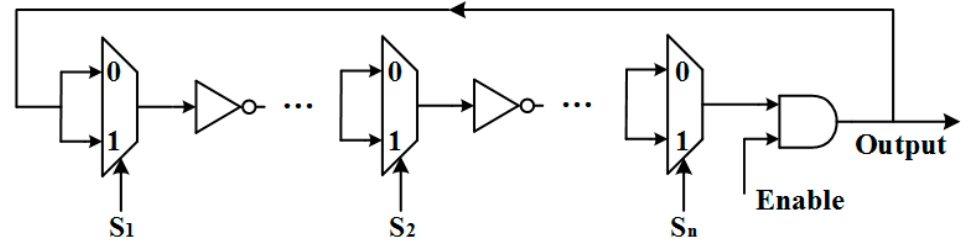
Figure 4. Architecture of the reconfigurable RO [18].